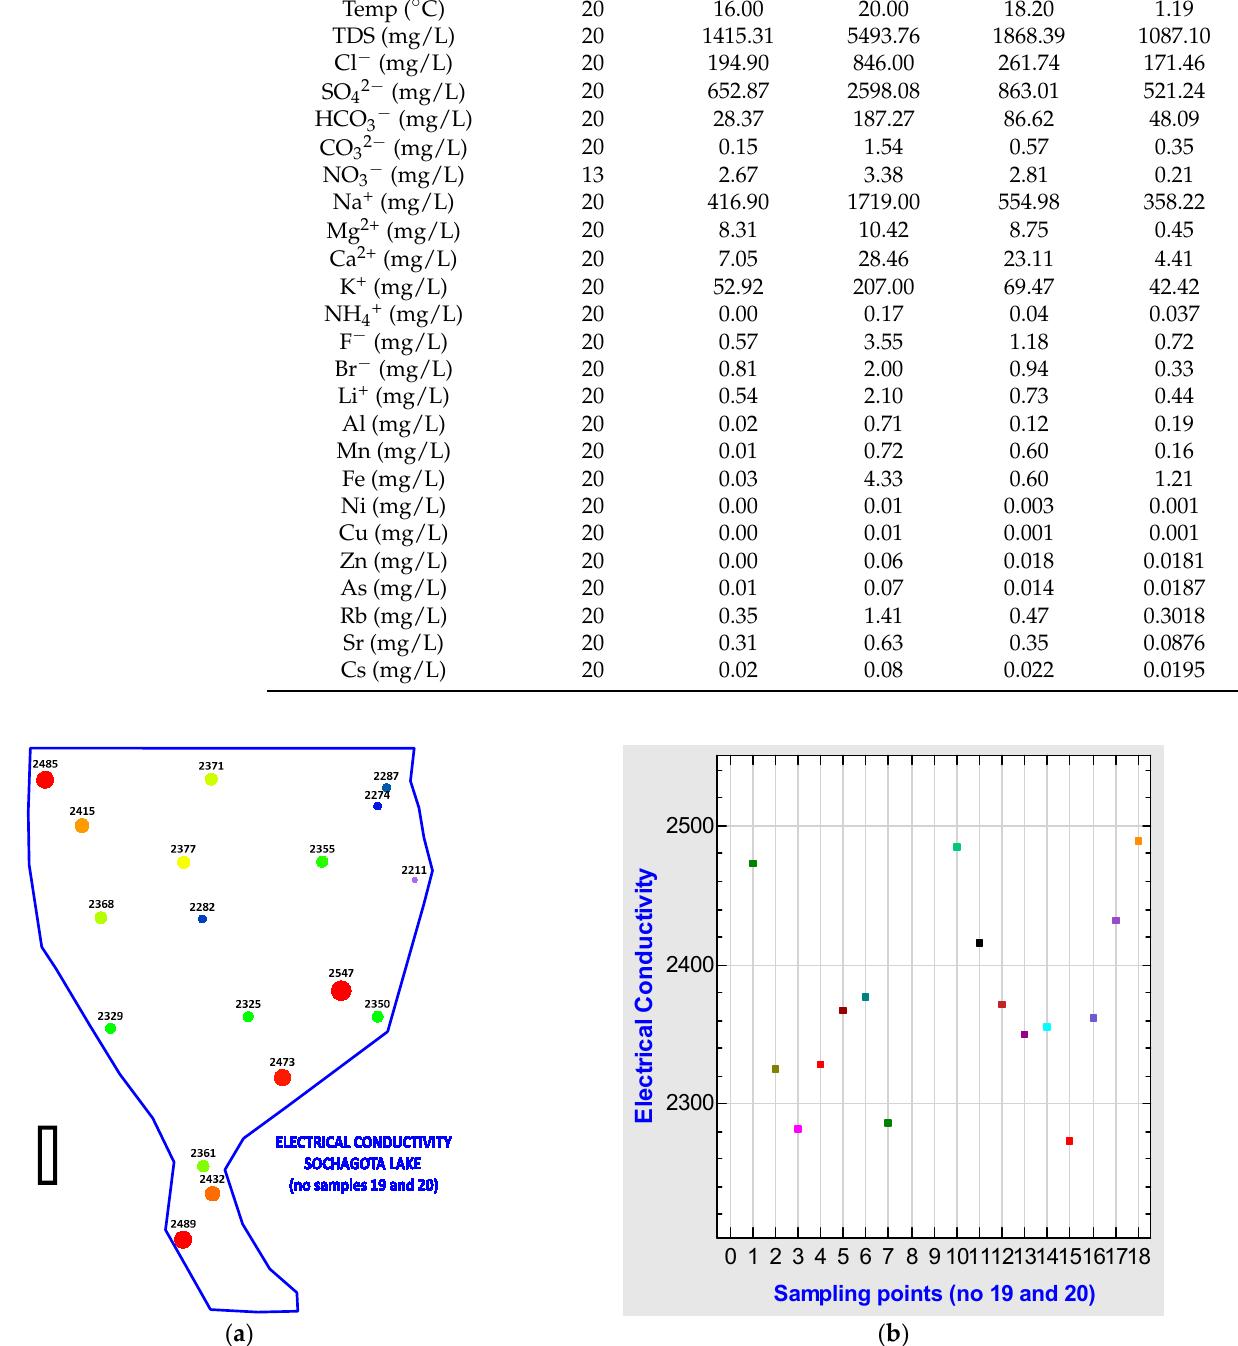
Figure 4. Values of electrical conductivity for samples 1 to 18 in the Sochagota Lake. Samples 19 and 20 have been removed to better illustrate the variation of the remaining samples, avoiding the screen effect of these high values. ( a ) Map of the E.C. in the lake with scaling size and corresponding value; ( b ) Plot of the values of E.C. vs. samples.